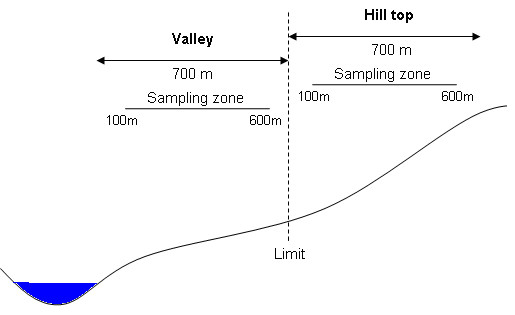
Representation of the valley and hill top areas, showing the sampling zones. From the valley floor, clusters in the valley where chosen at random between 100 and 600 metres. Clusters in the hill top were selected from 100 to 600 metres from the limit separating valley and hill top.